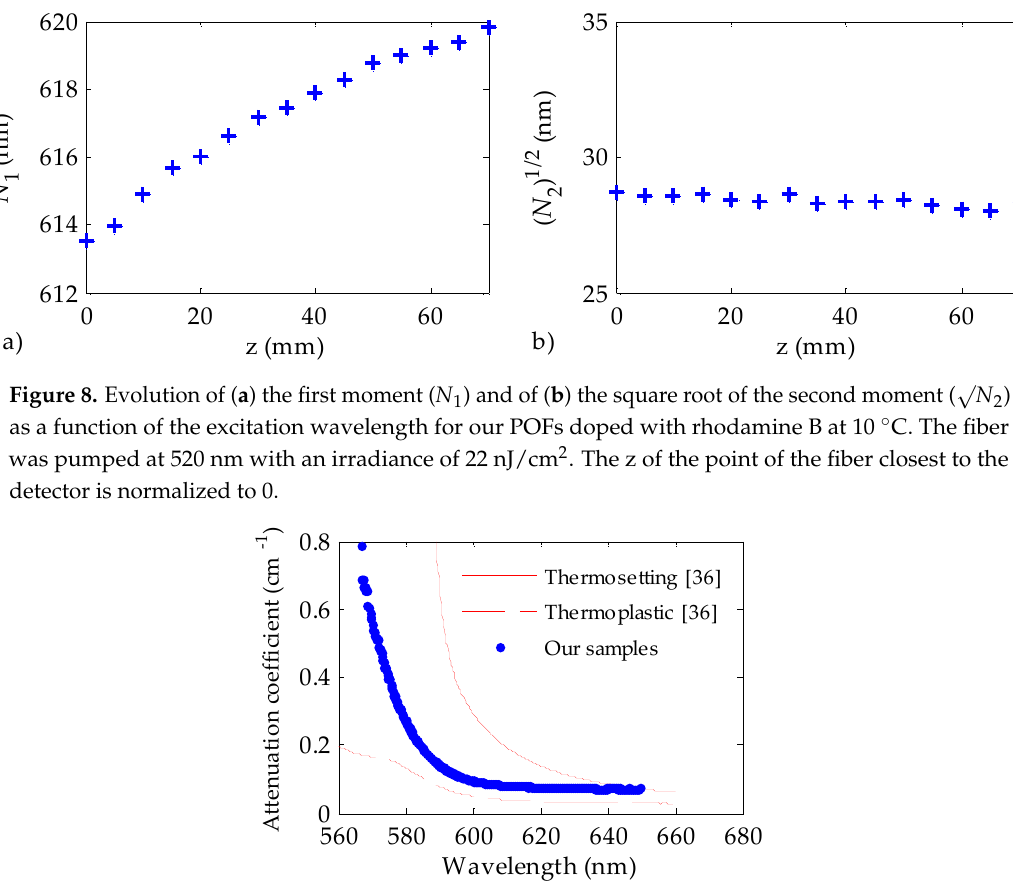
Figure 9. Linear attenuation coefficients of our POFs doped with rhodamine B at 10 °C (thick blue dots), together with those reported in [36] for thermosetting (thin solid line) and thermoplastic (thin dashed line) PMMA POFs doped with rhodamine 6G. The excitation wavelength and irradiance were 520 nm and 22 nJ/cm 2 , respectively.